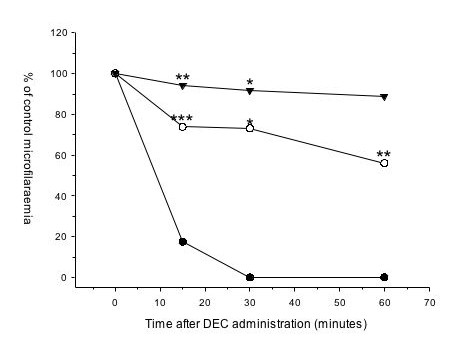
Indomethacin or dexamethasone pre-treatment reduces efficacy of DEC in BALB/c mice infected with B. malayi microfilariae. Indomethacin (10 mg/kg), dexamethasone (3 mg/kg) or vehicle was administered 30 minutes before oral dosing with DEC (100 mg/kg). Symbols are means of three mice for the DEC plus dexamethasone group (triangles), seven mice for the DEC plus indomethacin group (white circles) and four mice for the DEC-only group (black circles). Significantly different results from the DEC-only group are denoted by * (P < 0.017), ** (P = 0.001) or *** (P = 0.000).